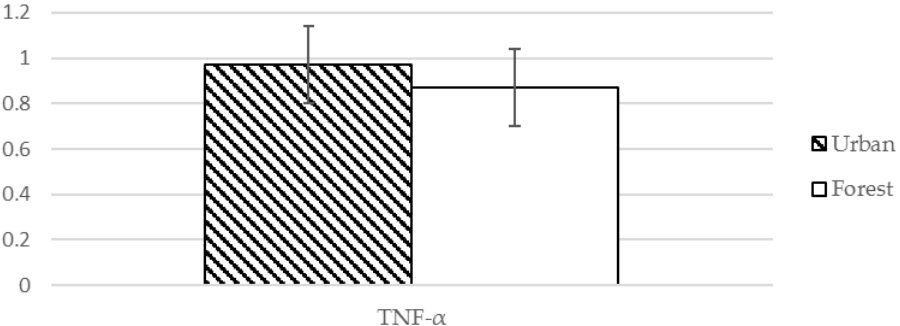
Figure 2. Effect of exposure to forest environment on GPx.